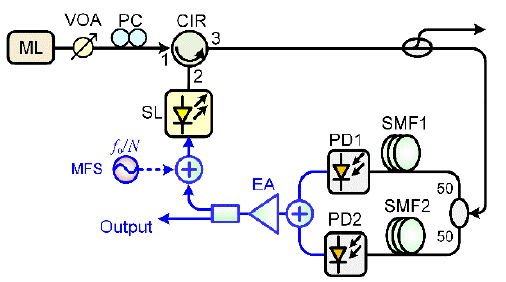
Figure 7. Photonic microwave stabilization for P1 dynamics using subharmonic microwave modu- lation and dual-loop optoelectronic feedback.